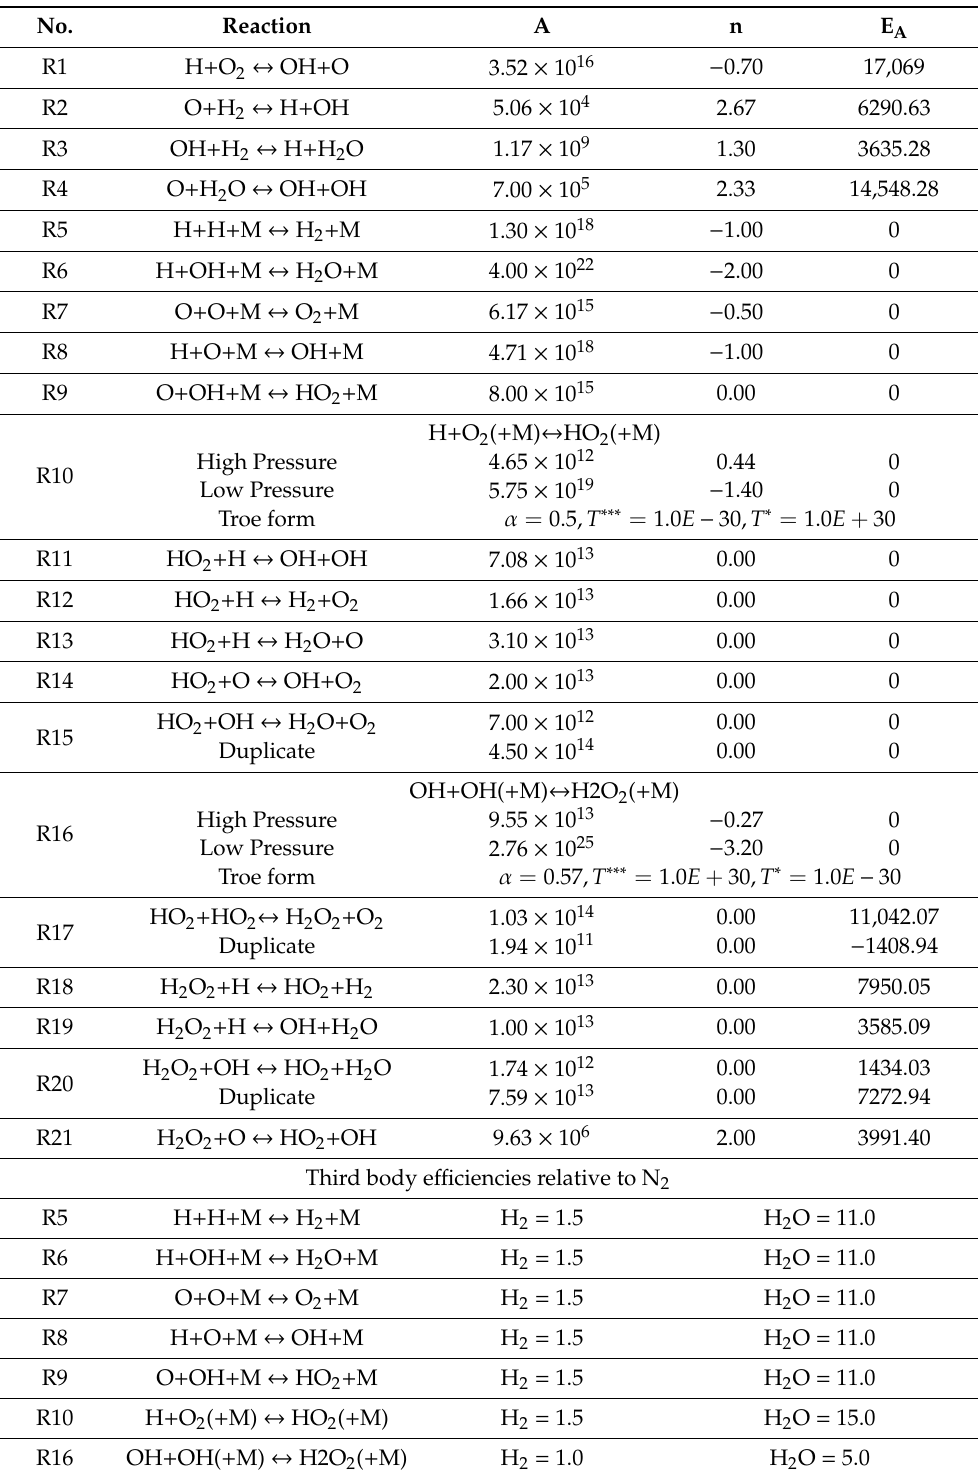
Table 1. Hydrogen / air pressure-dependent reaction mechanism introduced by UC San Diego